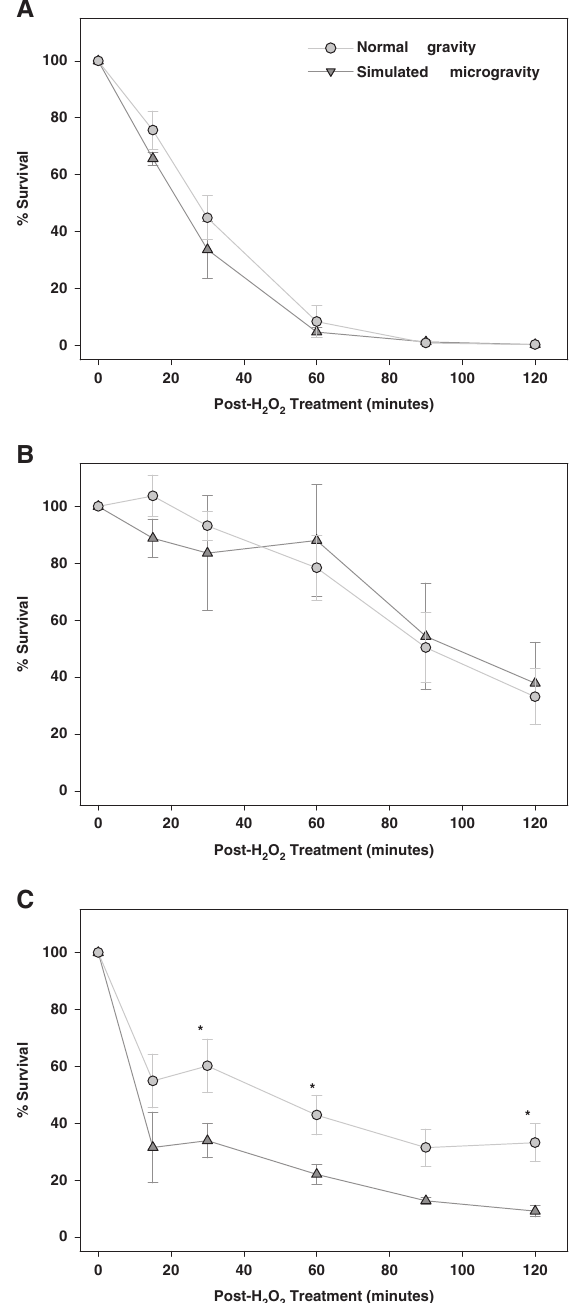
Fig. 5 Percent survival of S. mutans post-treatment with 5 mM H 2 O 2 . Cells from t = 4 ( a ), t = 8 ( b ), or t = 16 ( c ) hour simulated microgravity ( triangles ) and normal gravity ( circles ) HARV cultures ( n = 3 indepen- dent experiments per time point per growth condition) were harvested by centrifugation and resuspended in sterile HBSS. Samples were withdrawn to determine initial CFU/ml ( “ t = 0 ” ), and then H 2 O 2 was added to a fi nal concentration of 5 mM. CFU/ml of each cell suspension was sampled at 20, 40, 60, 90, and 120 min post-H 2 O 2 addition, and CFU/ml were determined. % Survival was calculated by 100 × [( t = fi nal CFU/ml)/( t = 0 CFU/ml)]. Error bars = SEM. Asterisk denotes statistical signi fi cance, one-tailed t test ( p < 0.05)